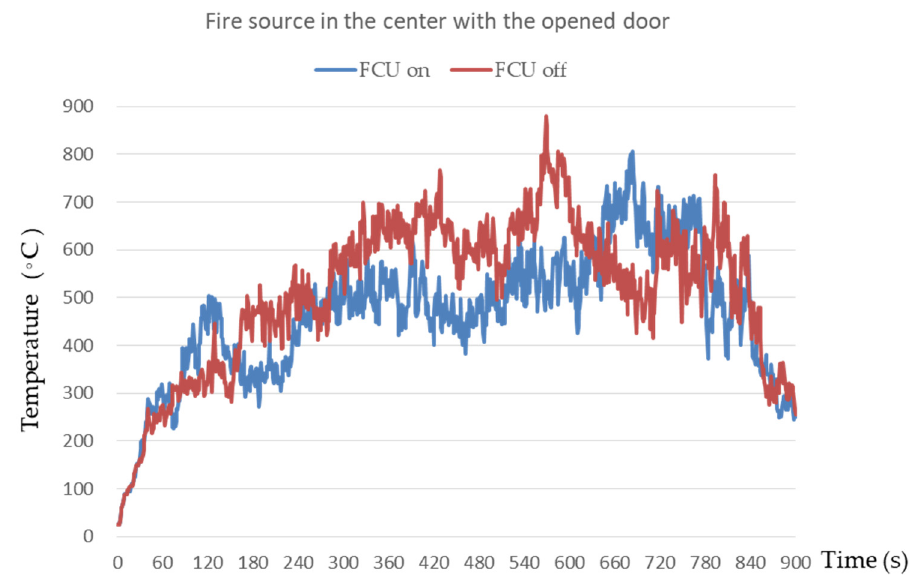
Figure 7. The average temperature for different actions of the air inlet with the fire in the center of the square room.